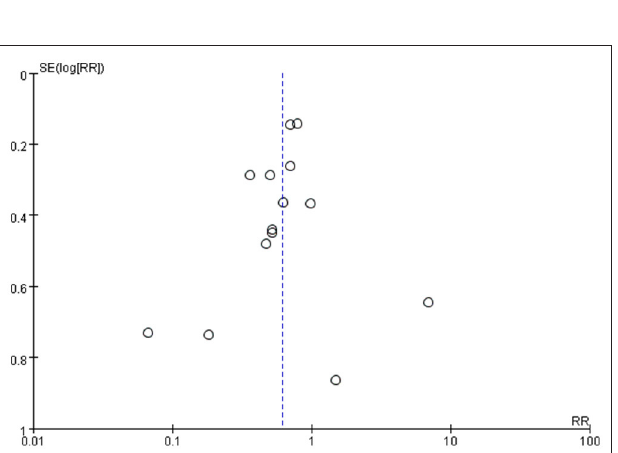
FIGURE 4 | Bias assessment plot (risk ratio). FIGURE 5 | Bias assessment plot (hazard